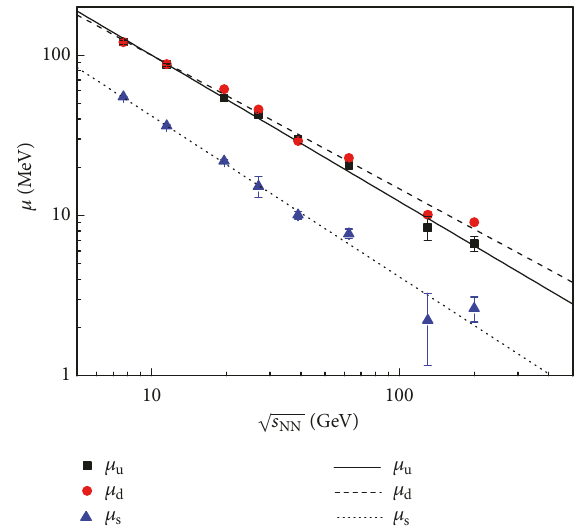
Figure 2: Correlations between 𝜇 𝑞 and √𝑠 𝑁𝑁 for central Au+Au collisions at RHIC. The symbols represent 𝜇 𝑞 obtained from the ratios by integrating the yield over the given 𝑝 𝑇 ranges available in experiments in Figure 1. The solid, dashed, and dotted curves are fitted results corresponding to 𝜇 𝑢 , 𝜇 𝑑 , and 𝜇 𝑠 ,